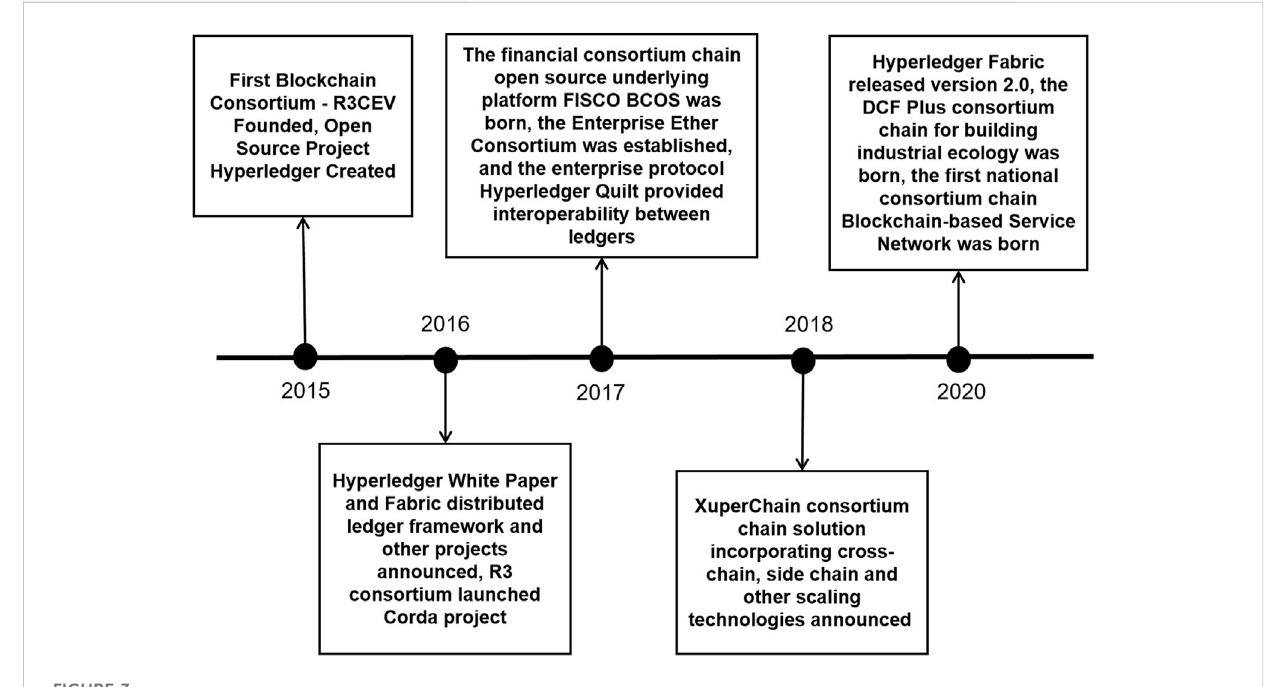
FIGURE 3 The development process of consortium chain